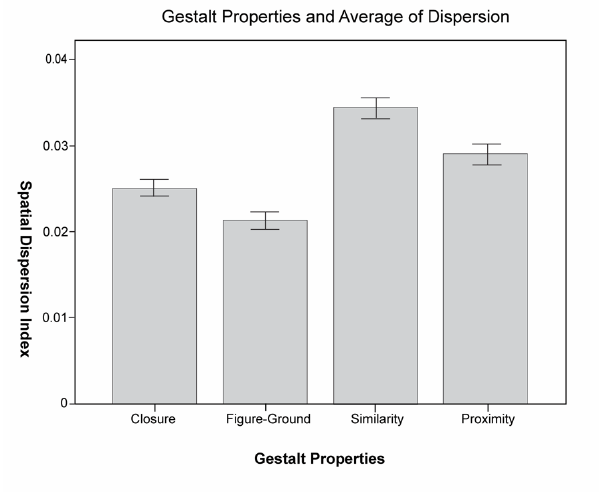
Figure 8. Dispersion of different gestalt